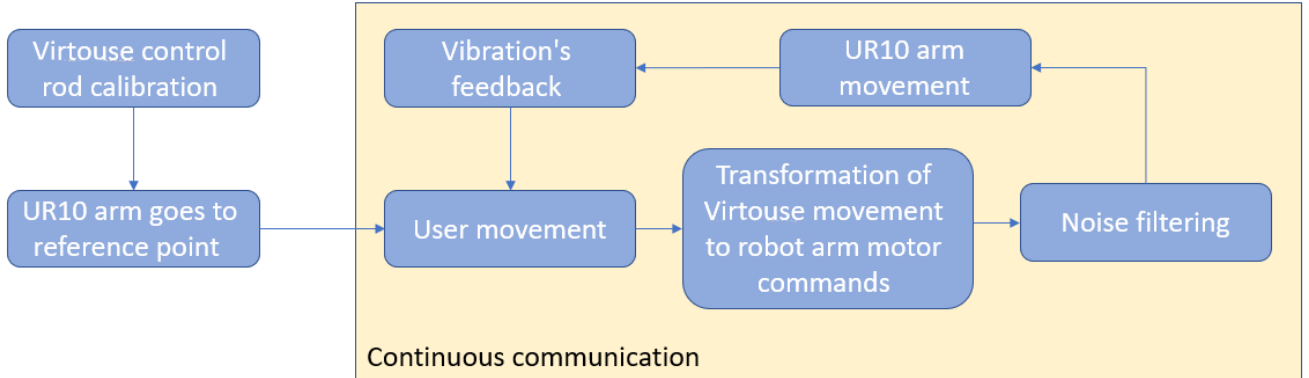
Figure 5. Communication between Virtouse control rod to UR10 robotic arm